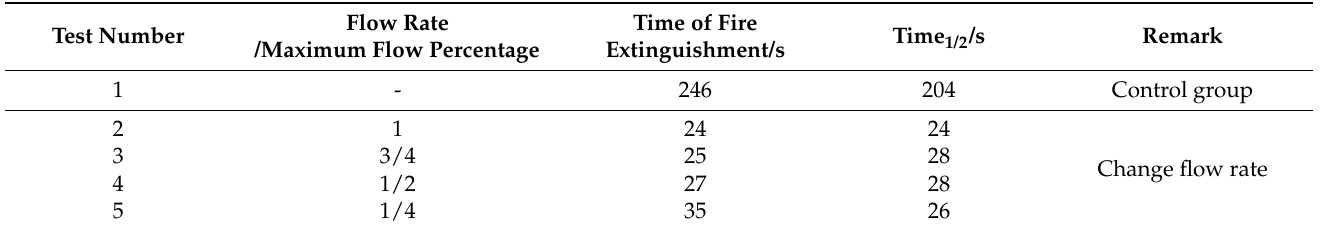
Table 2. Test results under different test conditions.